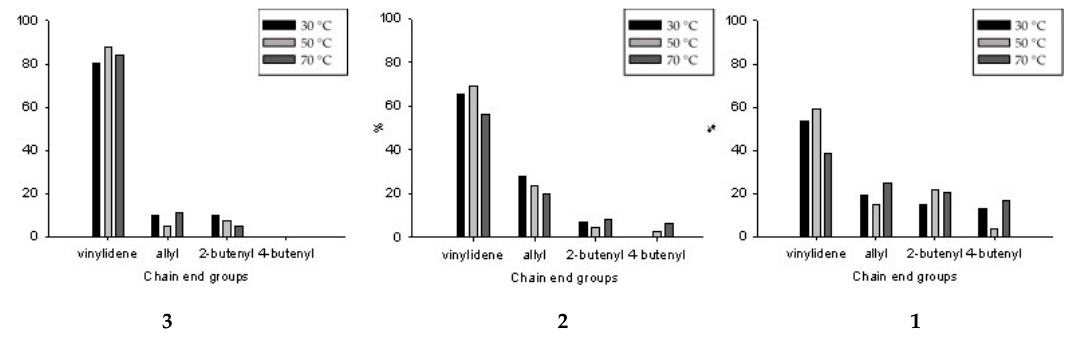
Figure 10. Relative changes of unsaturated end groups observed in PP obtained with 1 , 2 , and 3 catalysts at different temperatures. Vinylidene is the sum of vinylidene, internal vinylidene and isobutenyl end groups.